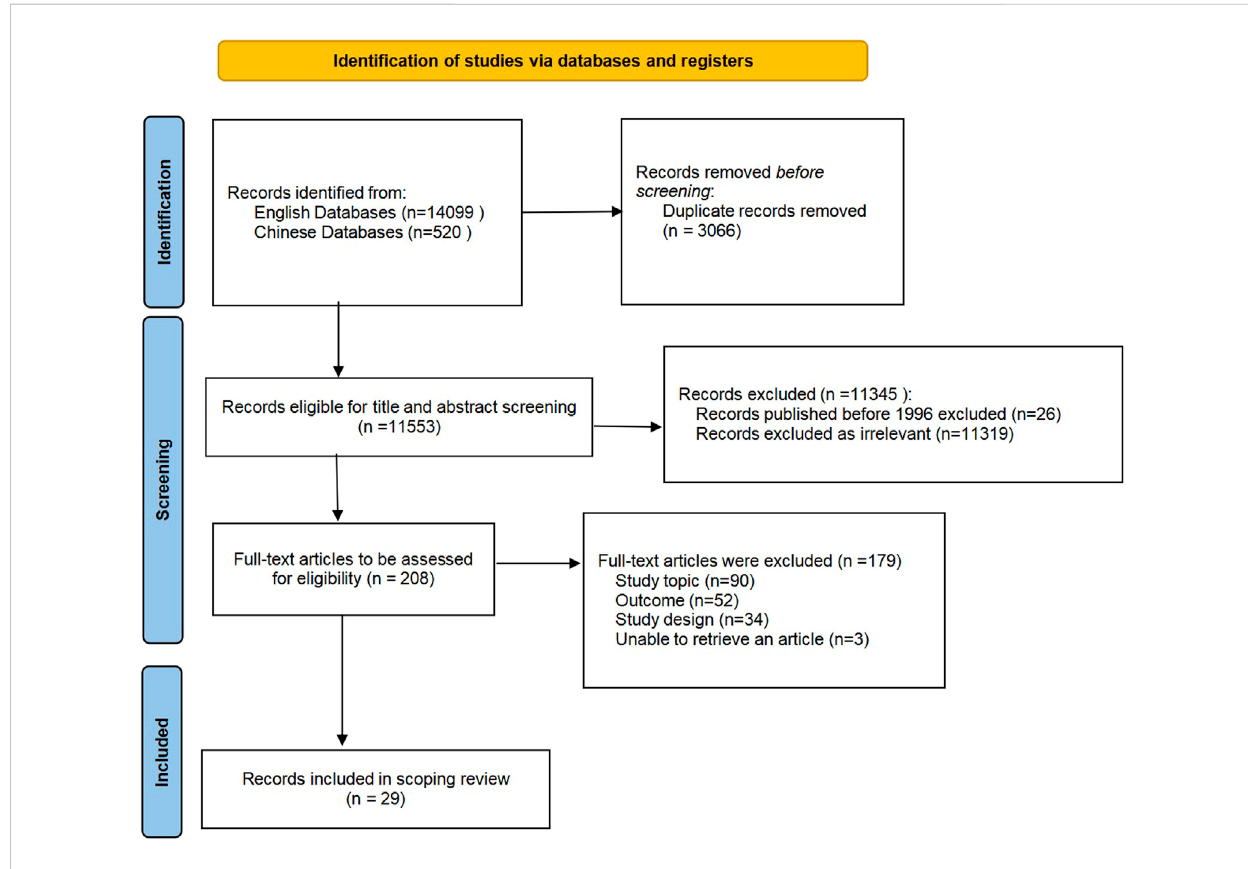
FIGURE 1 Flow diagram of study